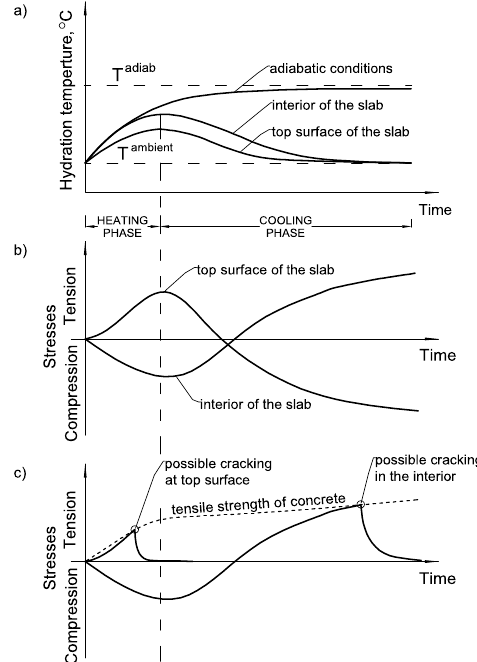
Figure 1. Temperature ( a ), stress ( b ) development and possible cracking ( c ) in mass foundation slab [5].